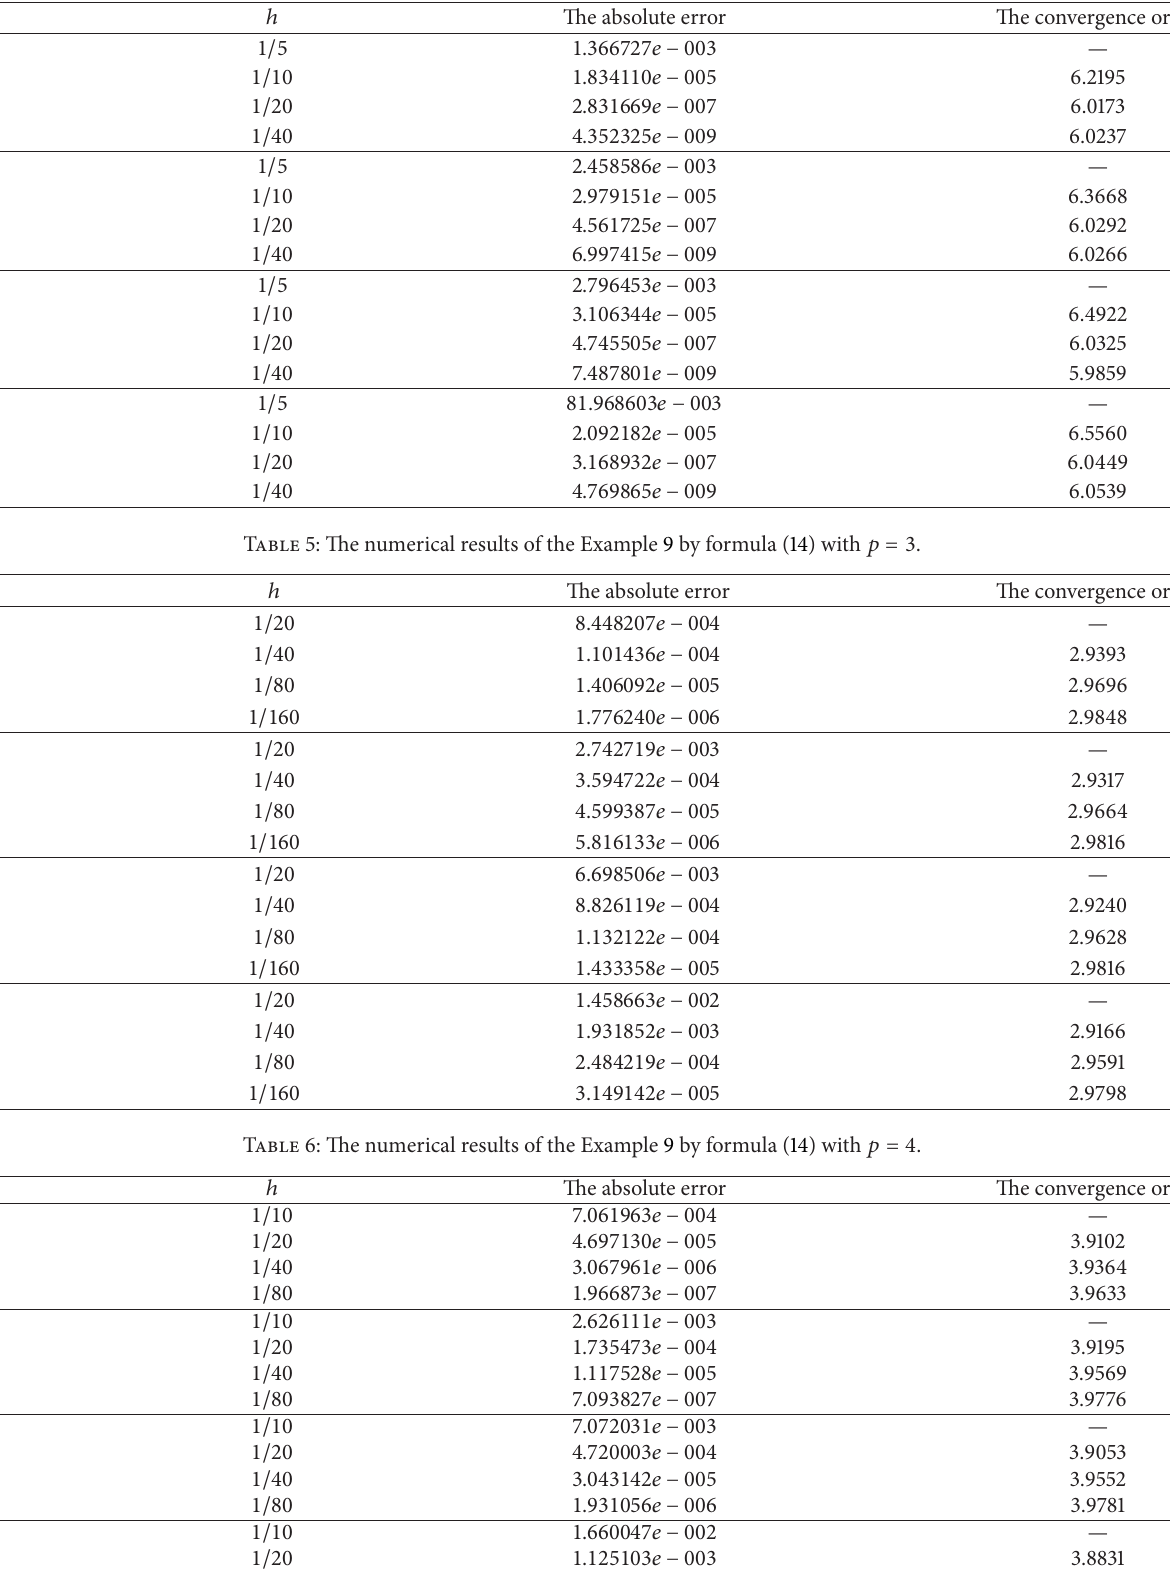
Table 4: The numerical results of the Example 8 with 𝑞 = 6 by formula (14) with 𝑝 = 6 .